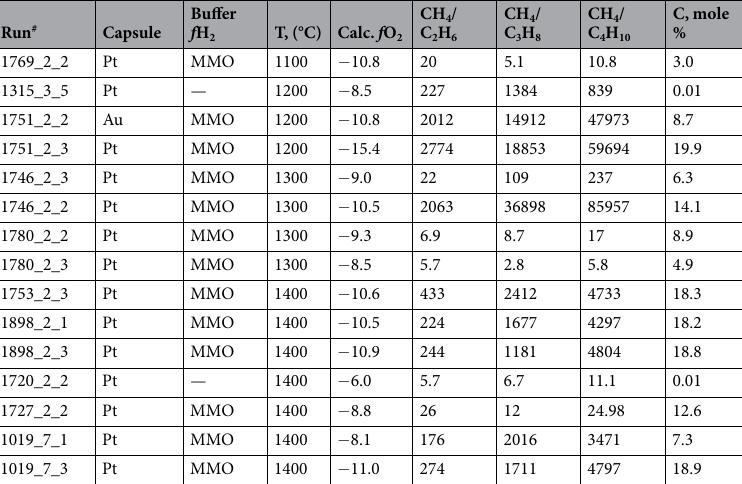
Table 7. Mole ratios of CH 4 , C 2 H 6 , C 3 H 8 and C 4 H 10 , carbon content (mole %), and calculated f O 2 in fluid phase, according to GC-MS calibration (see text for